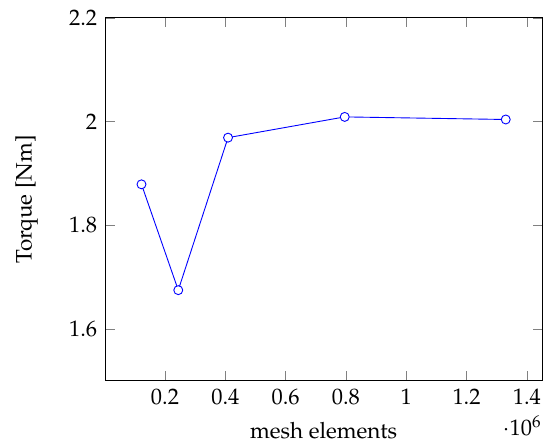
Figure 5. Mesh convergence study for the channel